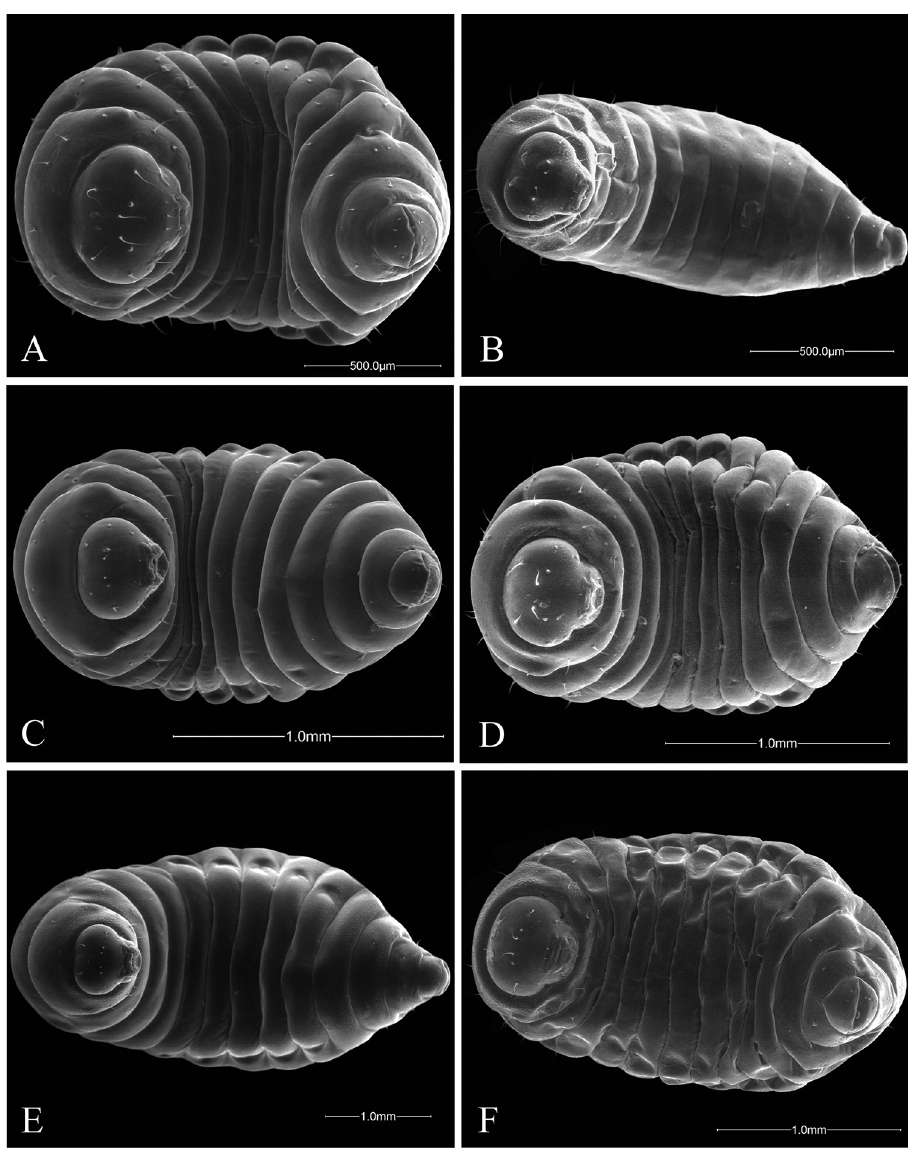
Figure 3. Ventral views of Ormyrus terminal-instar larvae. A Ormyrus capsalis B O. cupreus C O. diffinis D O. gratiosus E O. nitidulus F O. orientalis . Ormyrus gratiosus (Förster,